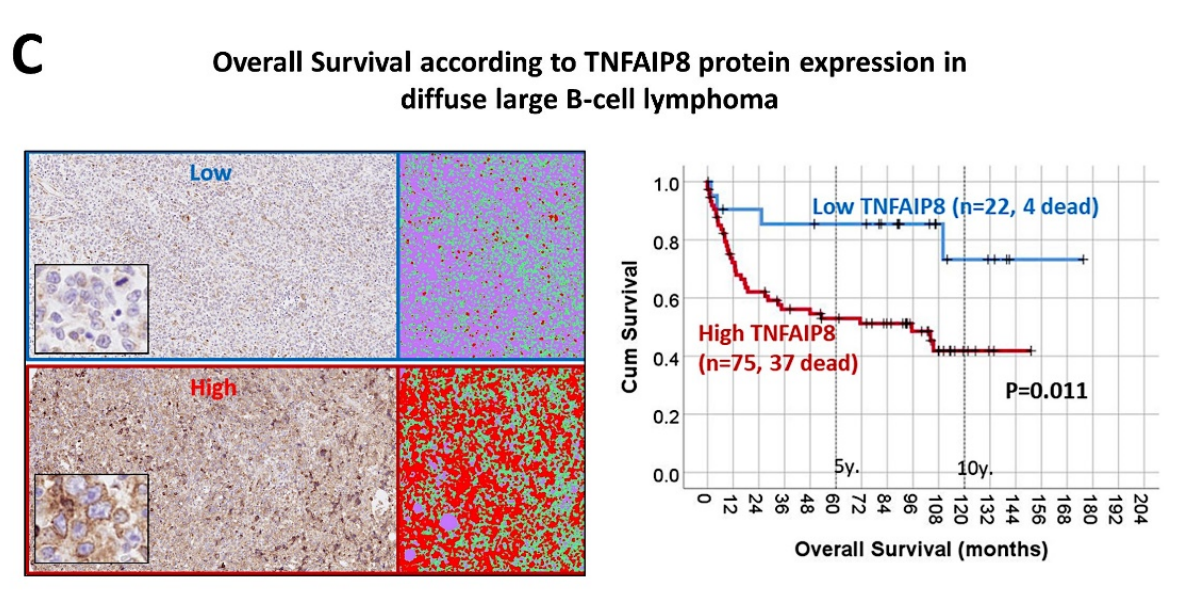
Figure 12. A set of 25 genes derived from a neural network predicted the overall survival of several lymphoma subtypes and acute myeloid leukemia, and high protein expression of TNFAIP8 correlated with poor survival of diffuse large B-cell lymphoma patients. ( A ) Using the gene expression values of 25 genes, previously identified using artificial neural networks, and a risk score formula, it was possible to predict the overall survival of several hematological neoplasia (lymphomas and acute myeloid leukemia). All Kaplan–Meier analyses with log-rank tests were statistically significant and had a p < 0.001. ( B ) Although all 25 genes were relevant, the strength and direction of the association was different in each subtype of hematological neoplasia. For example, TNFAIP8 was more relevant for the overall survival of diffuse large B-cell lymphoma and chronic lymphocytic leukemia, but less relevant for acute myeloid leukemia and multiple myeloma. Nevertheless, TNFAIP8 contributed to the survival of all these hematological neoplasia. ( C ) High TNFAIP8 protein expression, evaluated by immunohistochemistry using both conventional digital image analysis and AI-based methods, correlated with poor overall survival of diffuse large B-cell lymphoma patients. This figure shows two cases of diffuse large B-cell lymphoma. The figure at the top express low TNFAIP8. On the left, the hematoxylin (dark blue) and DAB-based (brown) immunohistochemical image is shown. As shown in the inset, the TNFAIP8 staining was cytoplasmic. On the right, the AI-based digital image analysis is shown for the same case and area. TNFAIP8 is highlighted in red, cellular structures (B lymphocytes of the lymphoma, T lymphocytes, and macrophages) in pink, and intercellular tissue in green. The figure at the bottom is characterized by high TNFAIP8 expression. After staining procedures, the immunohistochemical slides were digitalized and visualized (NanoZoomer S360 scanner and NDP.view2 viewing software, Hamamatsu KK.). Original magnification: 200 × . High TNFAIP8 correlated with age > 60 years, high serum IL2RA, non-GCB phenotype, and high infiltration of CD163+ M2-like tumor-associated macrophages (CD163+TAMs). TNFAIP8 also moderately correlated with MYC (Spearman’s correlation coefficient 0.389, p = 0.009) and Ki67 (proliferation index; Spearman’s correlation coefficient 0.48, p = 0.001). High TNFAIP8 was also associated (trend) with worse progression-free survival ( p = 0.052). Finally, a multivariate COX analysis between TNFAIP8 (high vs low) and the international prognostic index (IPI) (low+low/intermediate vs high/intermediate + high) showed that only TNFAIP8 retained the prognostic value (HR = 3.5, p = 0.040). CLL, chronic lymphocytic leukemia; DLBCL, diffuse large B-cell lymphoma; FL, follicular lymphoma; MM, multiple myeloma; MCL, mantle cell lymphoma; AML, acute myeloid